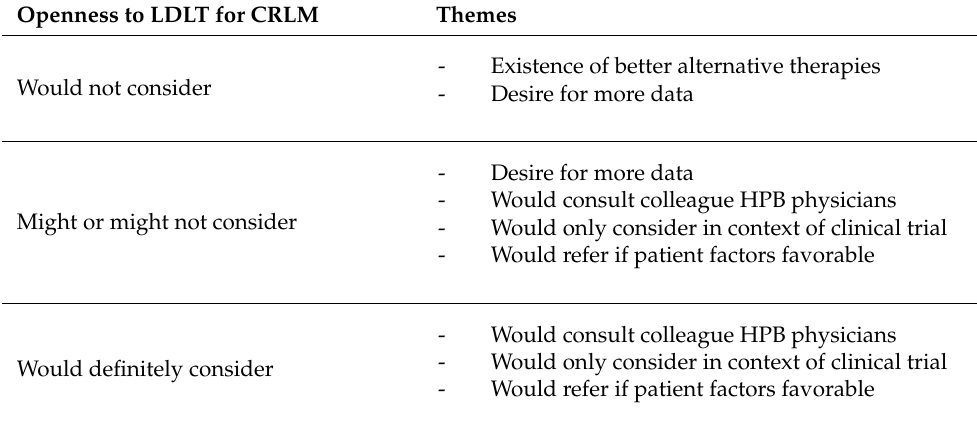
Table 5. Themes extracted from opinions related to surgeons’ inclination to refer patients for consid- eration for LDLT for